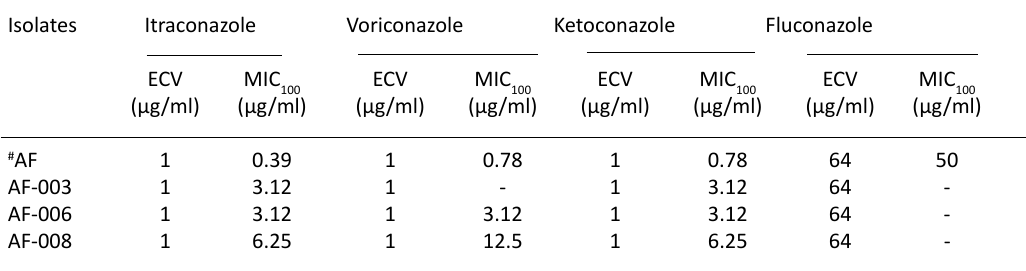
of Aspergillus isolates table 2. MIC 100 Isolates Itraconazole Voriconazole Ketoconazole